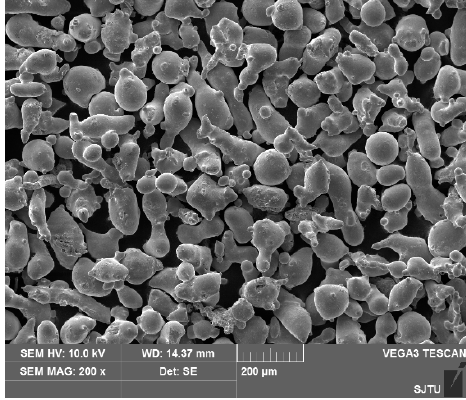
Table 2. The different parameters of orthogonal experiment groups.